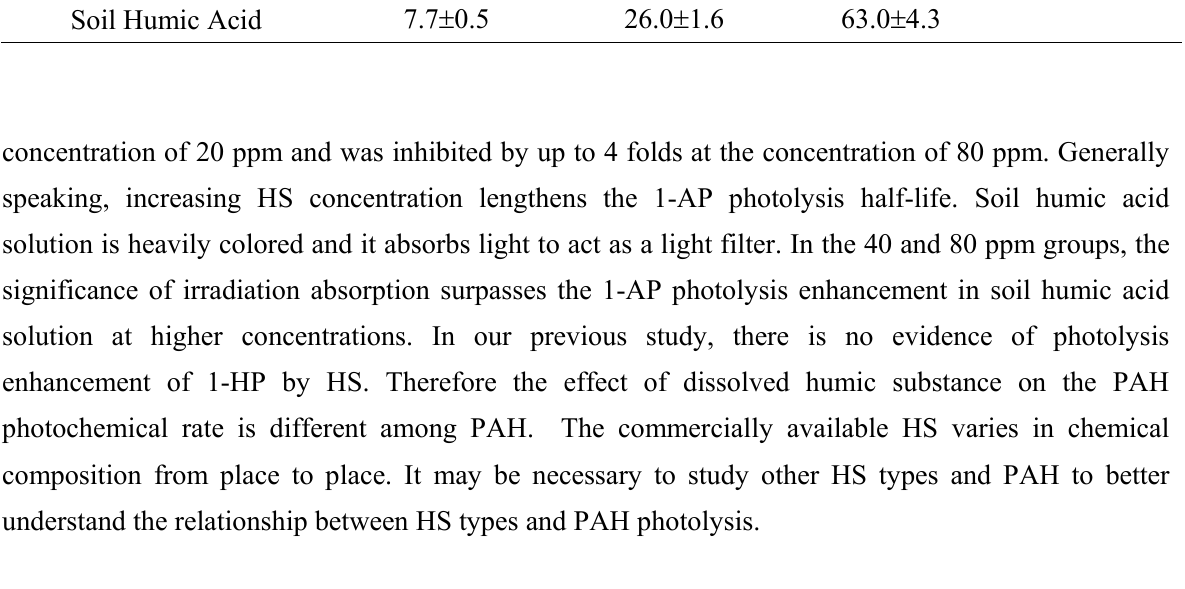
Table 1. 1-AP photodegradation half-life (t